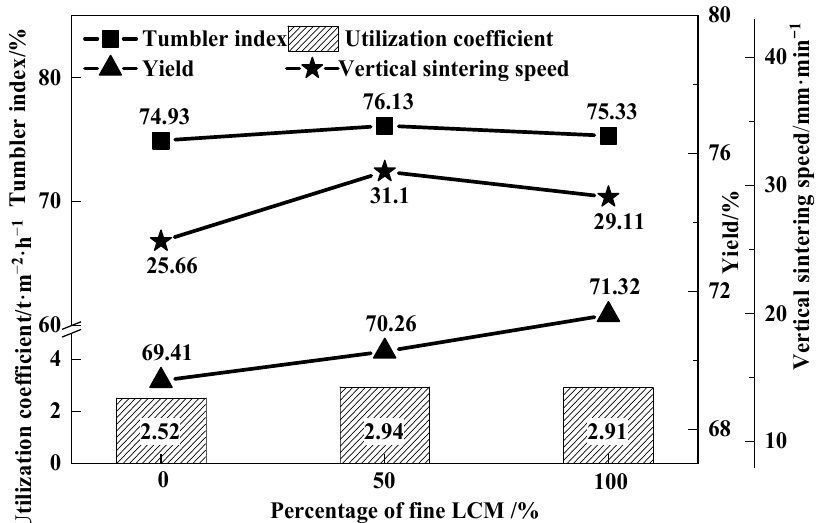
Figure 16. Effects of fine LCM on sinter index.